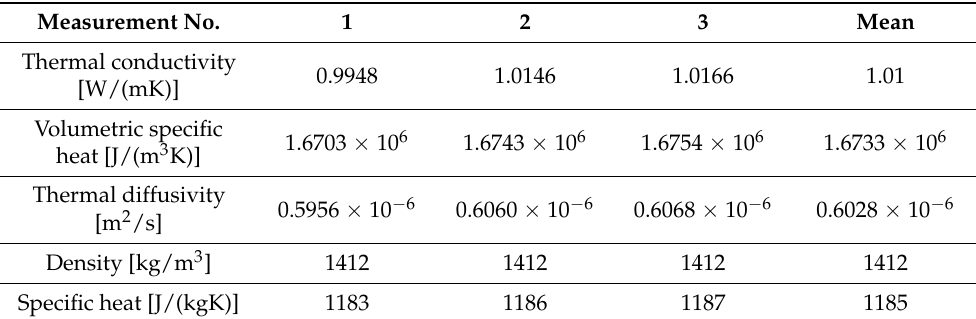
Table 1. Thermal properties of bricks from the described wall. Measurement No.